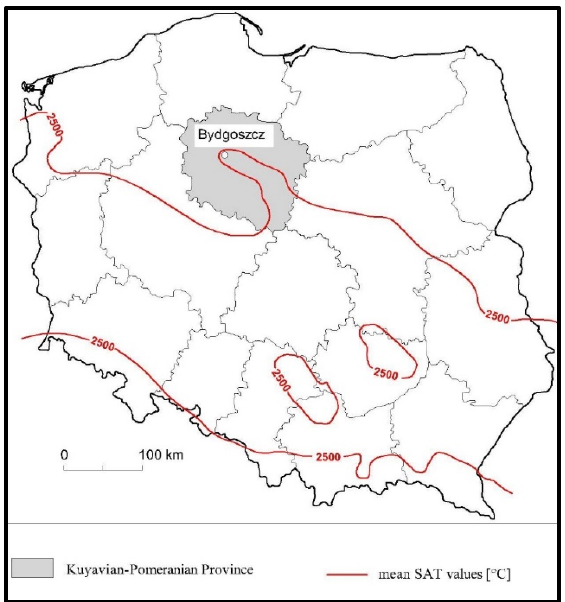
Figure 2. The borders of the Kuyavian–Pomeranian Province against the background of areas suitable for viticulture in Poland, which are limited by the isoline of the sum of active temperatures (SAT) 2500 ◦